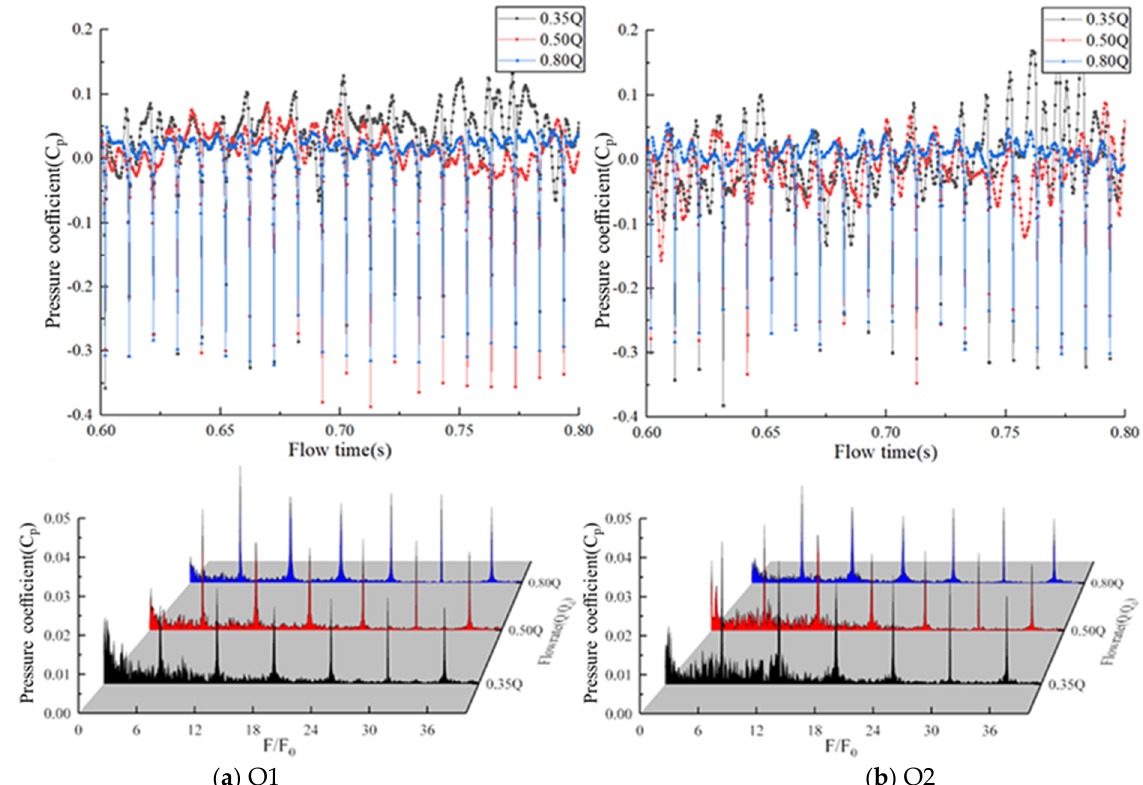
=4   ) at the outlet of 1